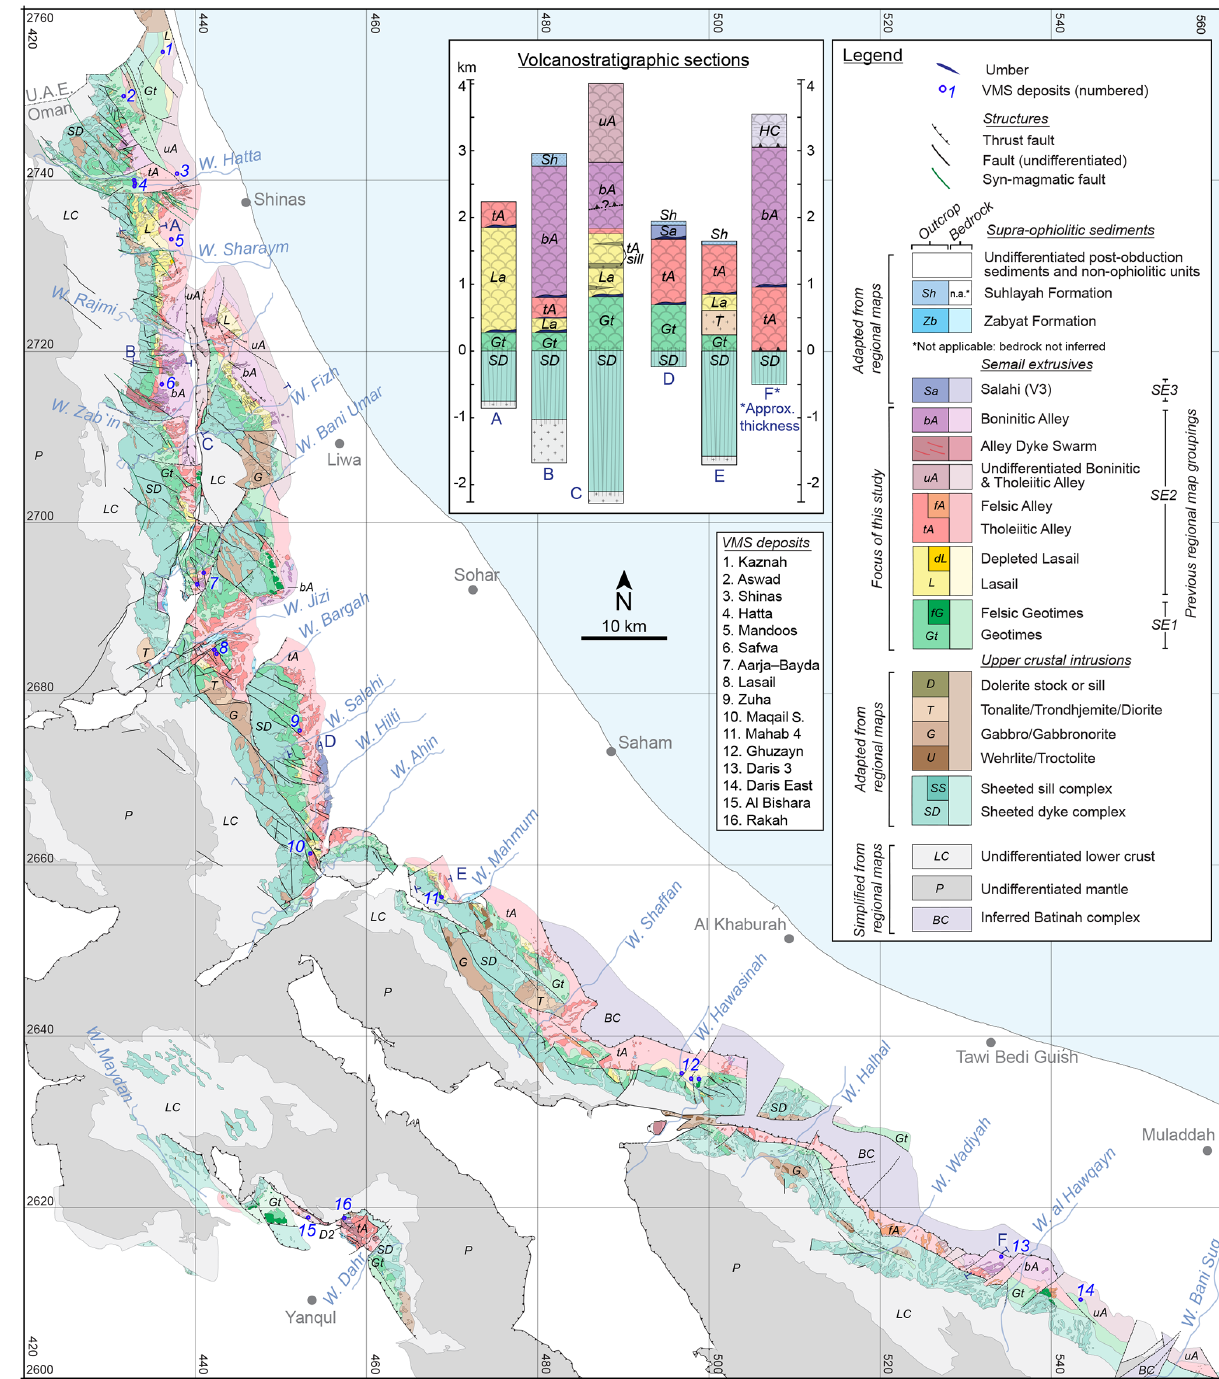
Figure 12. New map of volcanic units in the Semail ophiolite (this study). Strong colours: upper-crustal units in outcrop. Pale conjugate colours: upper-crustal units inferred as bedrock underlying sedimentary cover. Lower crustal and mantle rocks (copied and simplified from the regional map set) are shown for context. See Sect. 1.4 for changes versus previous maps and details on bedrock inferences under sediments. VMS deposit locations after Gilgen et al. (2014). The georeferenced multi-layer version of this figure, together with the mapping inputs in Fig. 11, is provided in the supplementary Geospatial